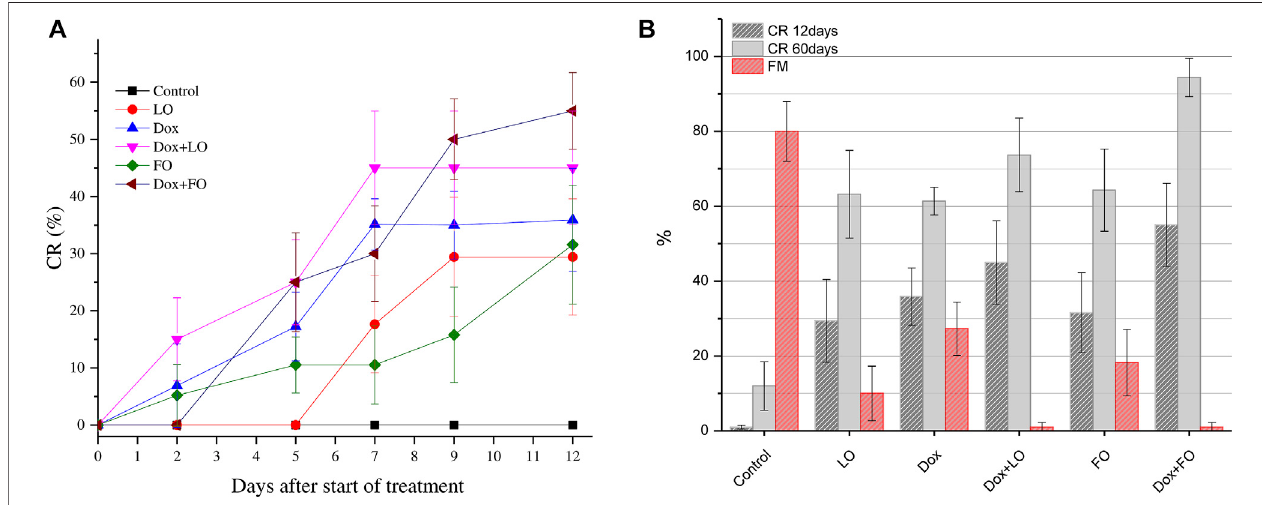
FIGURE 6 | Change in the frequency of complete LLC regressions during treatment for all studied groups (A) ; the CR value 12 and 60 days after the start of treatmentandfrequencyofmetastasis (B) .Thevaluesrepresentthemean±95%CI (A) andthemean%±SE (B) .Thedatacorrespondtotwoindependentexperiments.